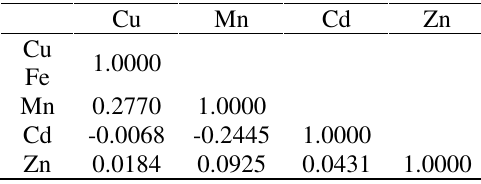
Table 4. Correlation